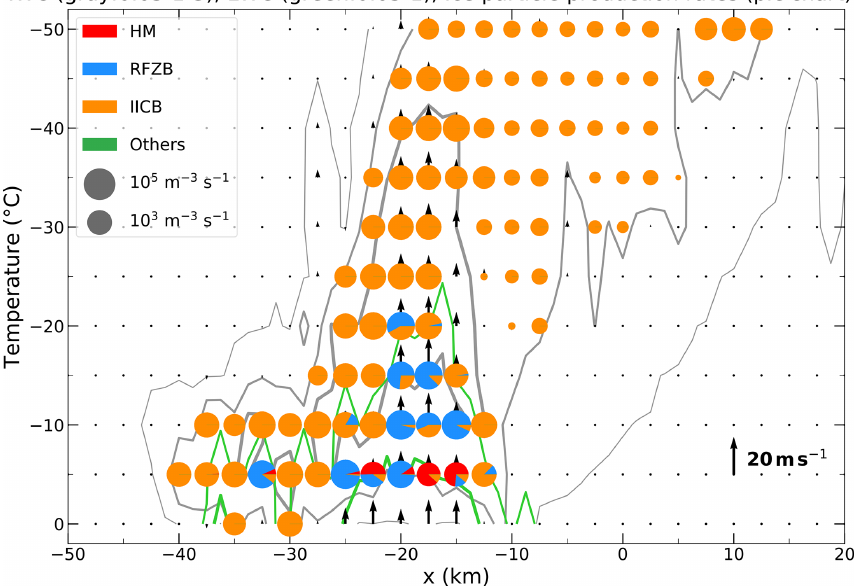
Figure 7. Vertical cross section along the line aligned along x shown in Fig. 2c of IWC (gray contours: 0.05, 1, and 3gm − 3 from thin to thick), LWC (green contours: 0.05 and 1gm − 3 from thin to thick), vertical velocity (vertical vectors), and the microphysical process rates relevant for ice particle production processes including (red) the H–M mechanism, (blue) shattering of freezing droplets, (orange) fragmentation of ice–ice collision, and (green) other microphysical processes (i.e., ice nucleation, homogeneous and heterogeneous freezing of cloud droplets and rain) in regions with IWC > 1gm − 3 at different temperatures in SIPs250m at t = 60min. The pie charts denote ice particle production rates summed over all the source terms with the area of each color proportional to the ice particle production rate.